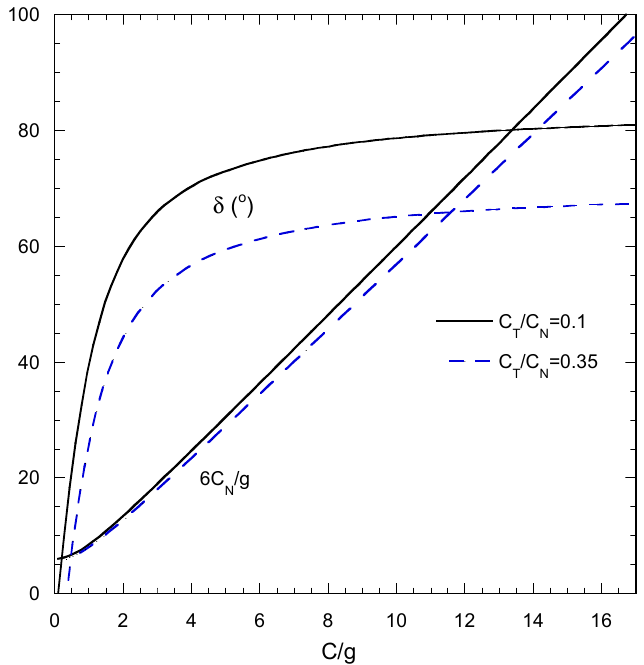
Figure 8. The required centrifugal acceleration C- tilting angle δ trajectory to ensure a constant ratio of acceleration components; in practice for two values of this ratio. The value of normal component C N is also shown.